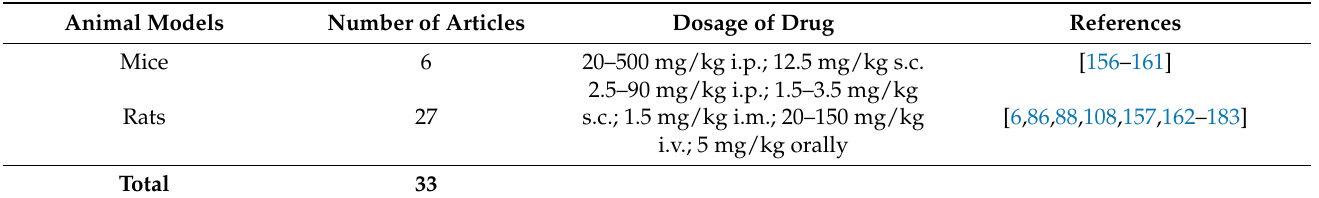
Table 4. Summary of data collected from in vivo animal studies involving methotrexate-induced intestinal mucositis. Drug concentrations obtained from studies are listed in a range of minimum to maximum dosage administered in animal